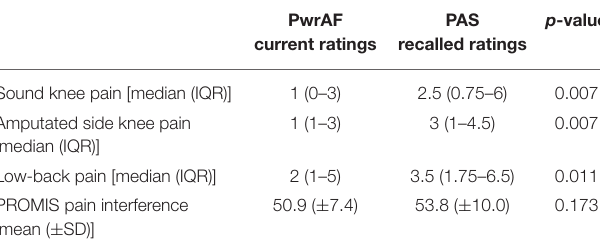
TABLE 2 | Original pain and pain interference in current PwrAF